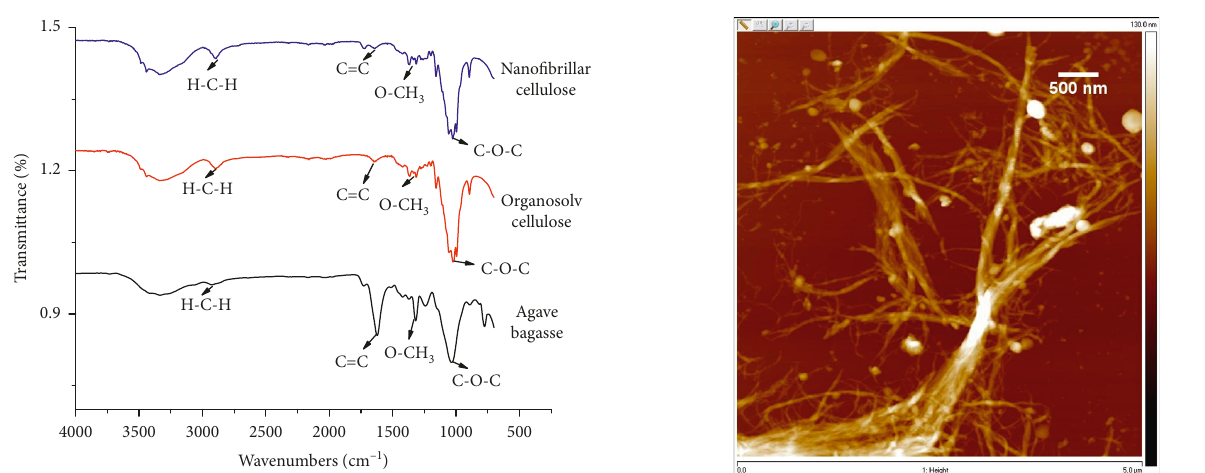
Figure 3: AFM image of cellulose bagasse nanofibril